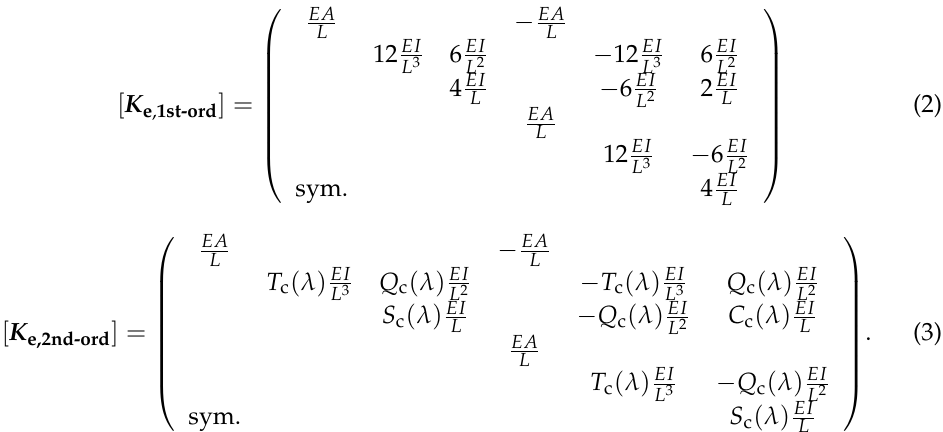
Figure 1. Axial-loaded beam–column with element-end displacements and forces. For first-order (e.g., [21,22]) and second-order (e.g., [10,13–16,19]) analysis (i.e., without and with considering the geometric nonlinearity), the element stiffness matrix of a beam- column element can be formulated as Equations (2) and (3), respectively.